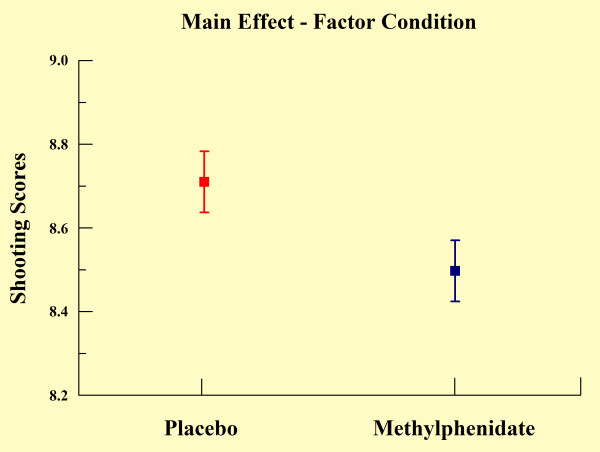
Main effect for factor condition observed through mean and SD (p < 0.041).